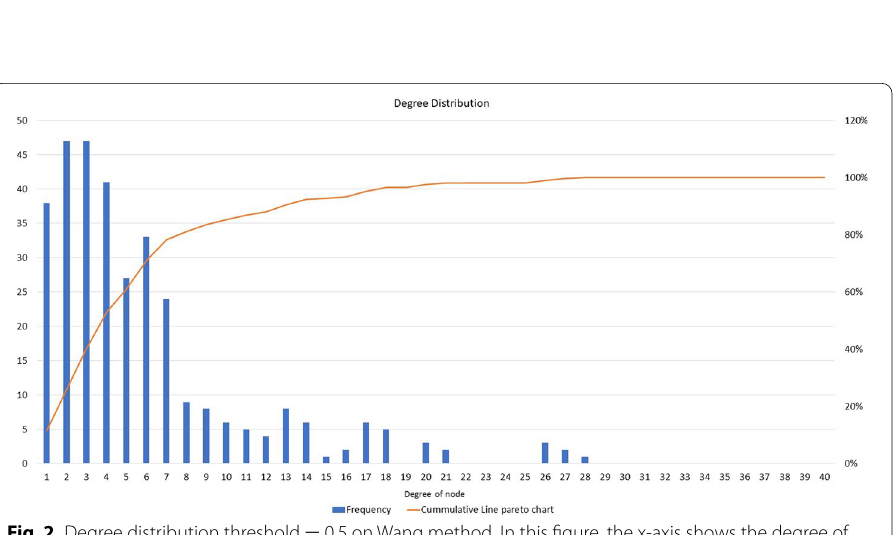
Fig. 2 Degree distribution threshold 0.5 on Wang method. In this figure, the x-axis shows the degree of = a node in the network, and the y-axis shows the frequency of nodes that have a particular degree (blue bar chart) and their cumulative frequency (orange